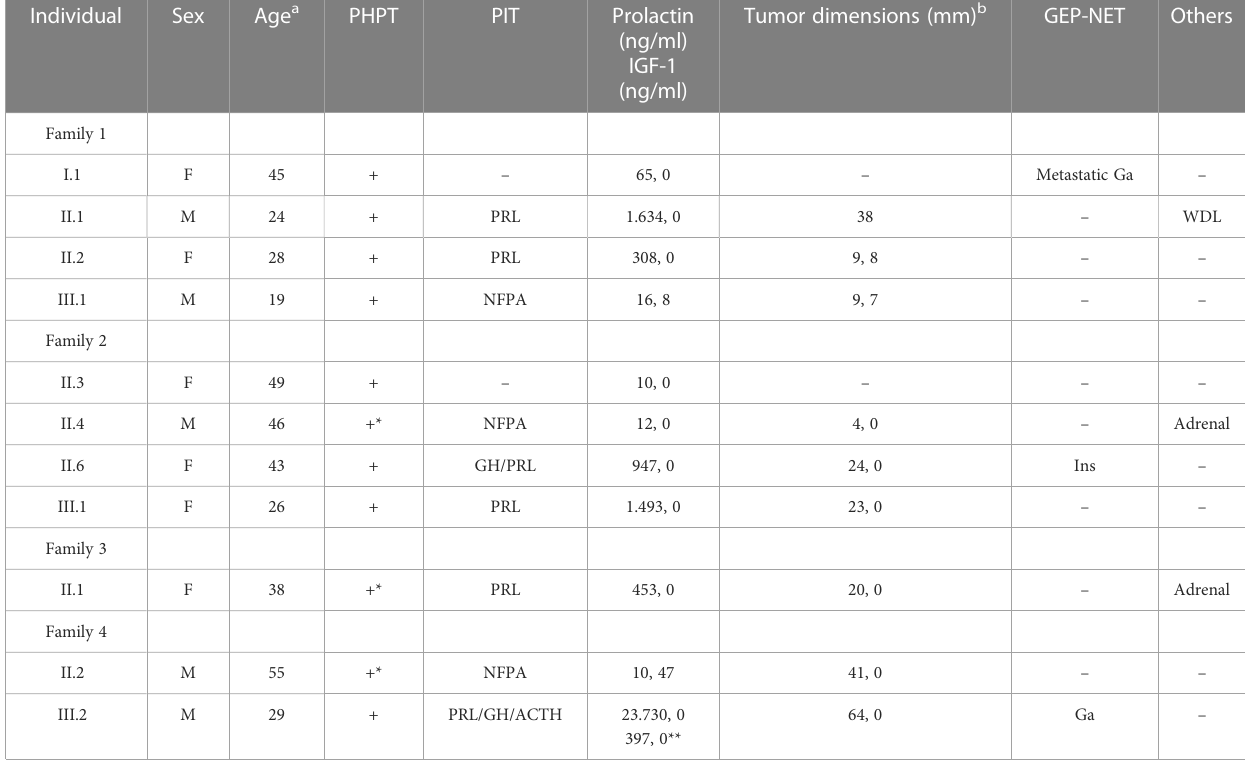
TABLE 1 Clinical characteristics of subjects from four families with clinical MEN1.